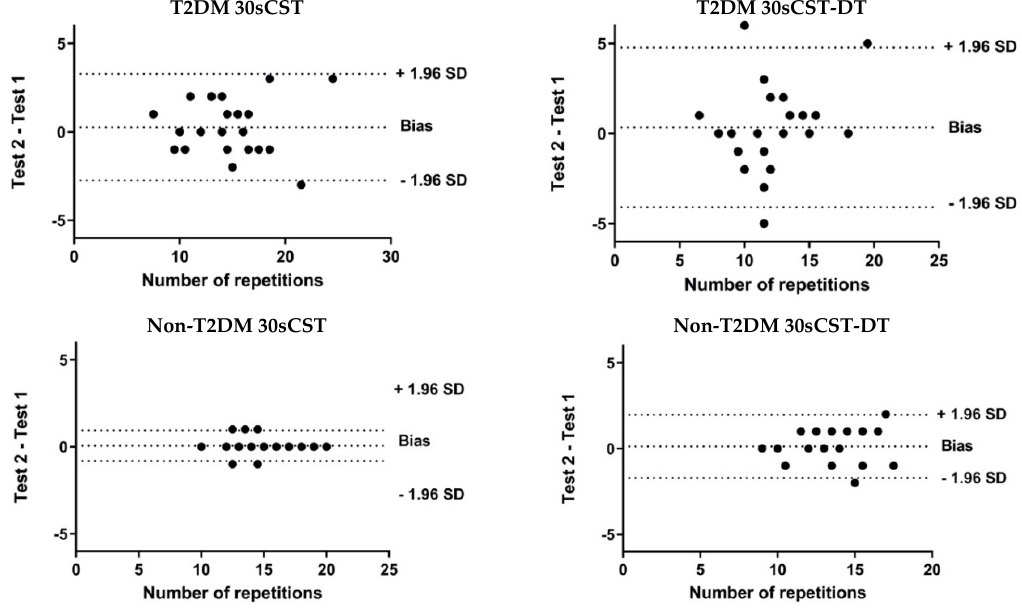
Figure 1. Bland–Altman’s graphs for 30-s chair stand test and 30-s chair stand test with and without dual-task.